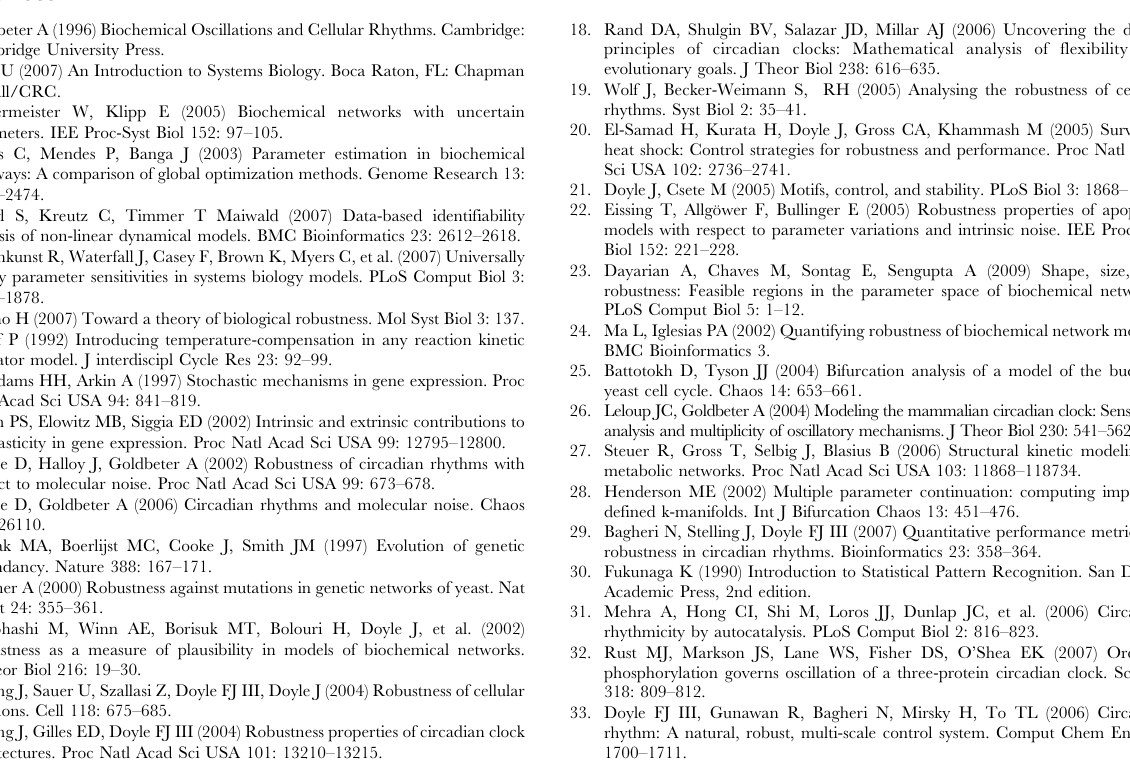
plotted against k 2 . In the autocatalytic model, k 1 has a Spearman’s correlation coefficient with r N of 0.921 (p , 10 2 323 , n= 1828) and less that 6 percent of the parameter vectors have a score above 0.5. For the two-sites model, k 2 has a correlation coefficient with r N of parameter vectors have a score above 0.5. Figure S3 (A) Distribution of the scores for the robustness to parameter perturbations (autocatalytic model in red and two-sites model in blue), similar as Figure 4B. (B) Distribution of the scores for the robustness to temperature changes. The results are obtained with the same algorithm as the one for r P but the random variates are correlated such that for a particular perturbation all parameters are either increased or decreased. In this case, the median robustness for the two-sites model is only 4 percent larger than the median of the autocatalytic model (p = 2.28 6 10 2 4 , Wilcoxon rank sum test). Figure S4 Illustration of the proposed sampling approach based on interval constraints. The a priori sampling range (light-gray) and two systemic properties p 1 and p 2 allowed to assume values in predetermined intervals induce constraints in parameter space and partition it into regions that are viable and those that are not. The parameter region preserving p 2 is unbounded, accounting for the situation of unidentifiability and indicates the necessity for an a priori sampling range. Figure S5 The importance of incorporating volume information in estimating global robustness. One might argue that it would be sufficient to just use the ratio C= | V |/| S | as a measure of global robustness. This is not the case if one wants to compare models where both the geometry and the size of a model’s viable set